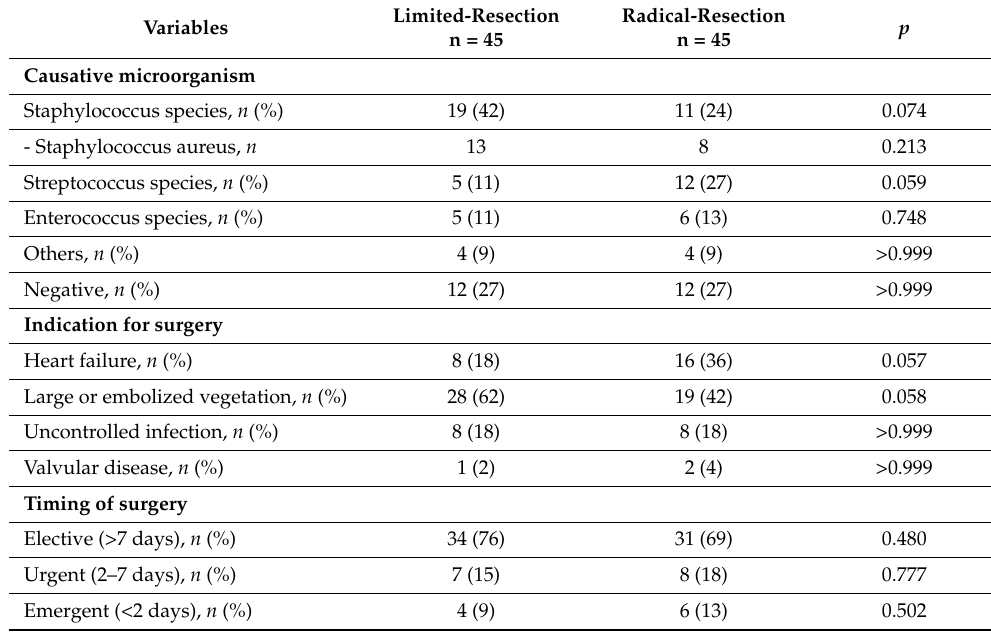
Table 2. Causative microorganism and surgical indication and